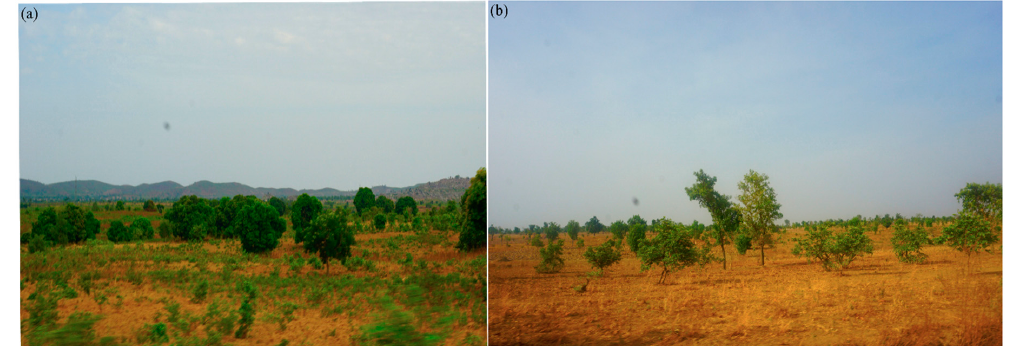
Figure 2. ( a ) Landscape showing a degraded patch of the Nigerian savannah vegetation in Shiroro local government area, Niger state, Nigeria; ( b ) a mix of degraded land with few bushes and trees interspersed in Borgu local government area, Niger state, Nigeria. (Source: own fieldwork, 2019).